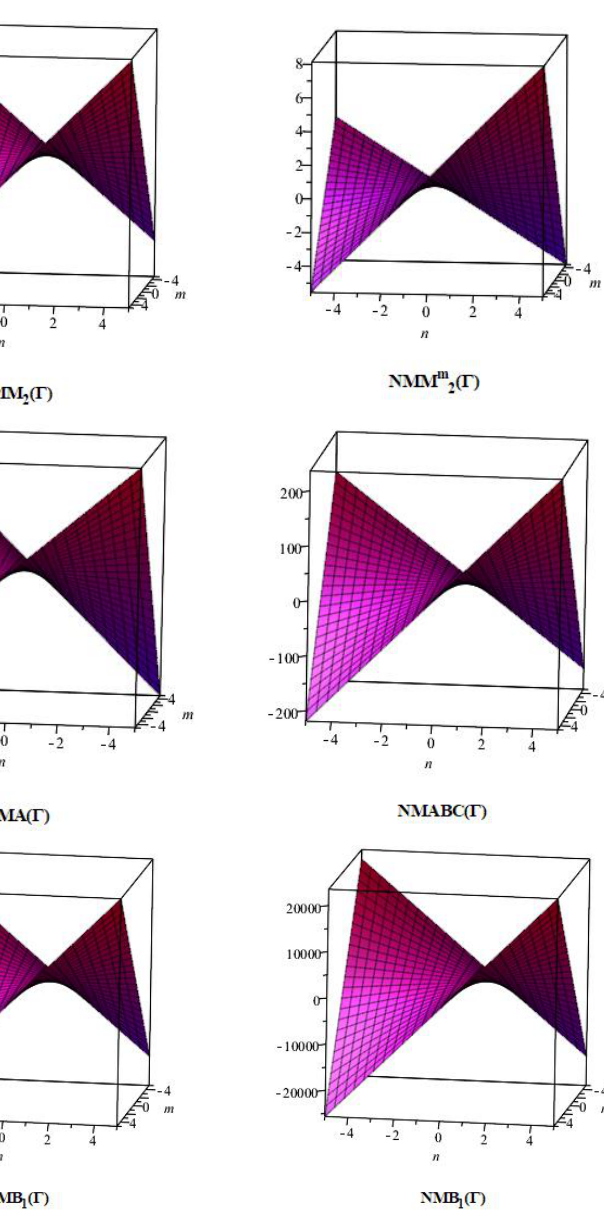
Figure 2. 3D plots for Theorem 2.